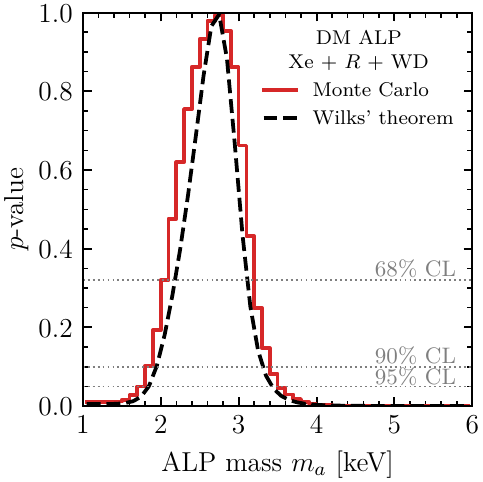
Figure 9. Monte Carlo simulations of p -values for the DM ALP mass (red contours) compared to the confidence interval from figure 4 obtained using Wilks’ theorem (dashed black